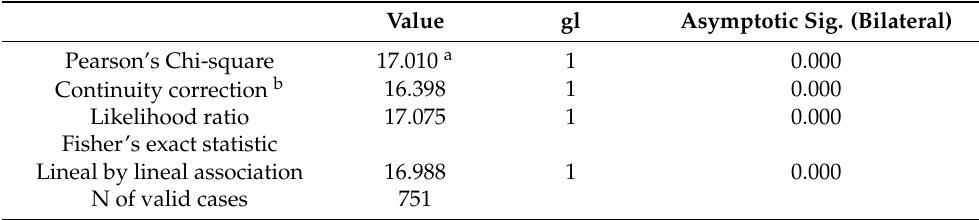
Table A2. Chi-square test